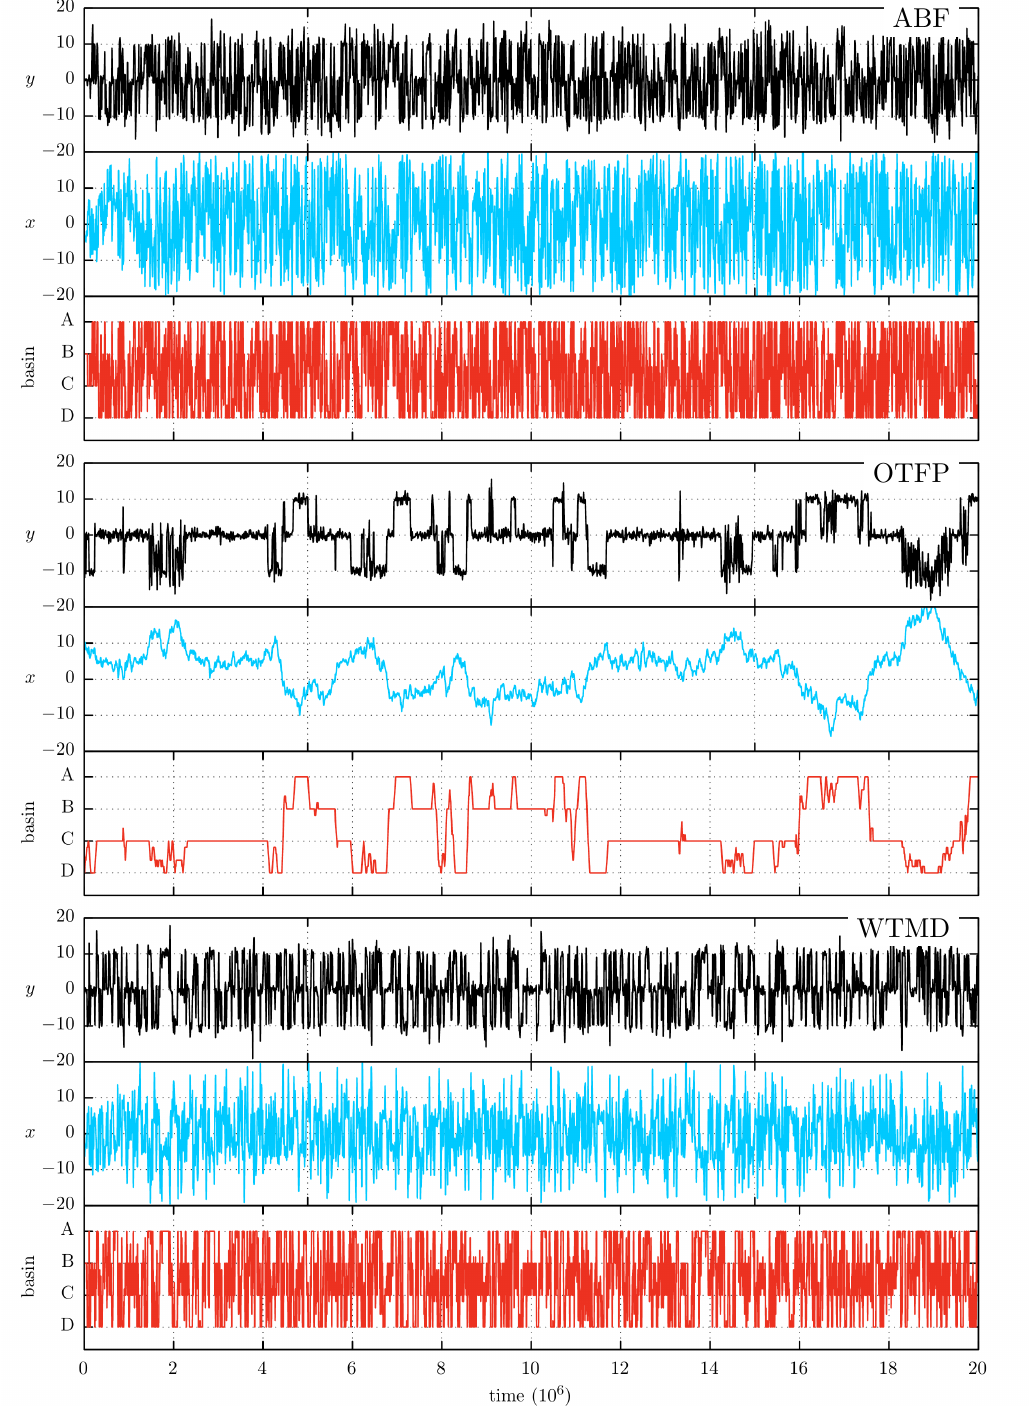
Figure 4. The position trace of representative ABF, OTFP and WTMD simulations associated with the results shown in Figure 3. For each method, x , y and basin assignation are shown in black, blue and red